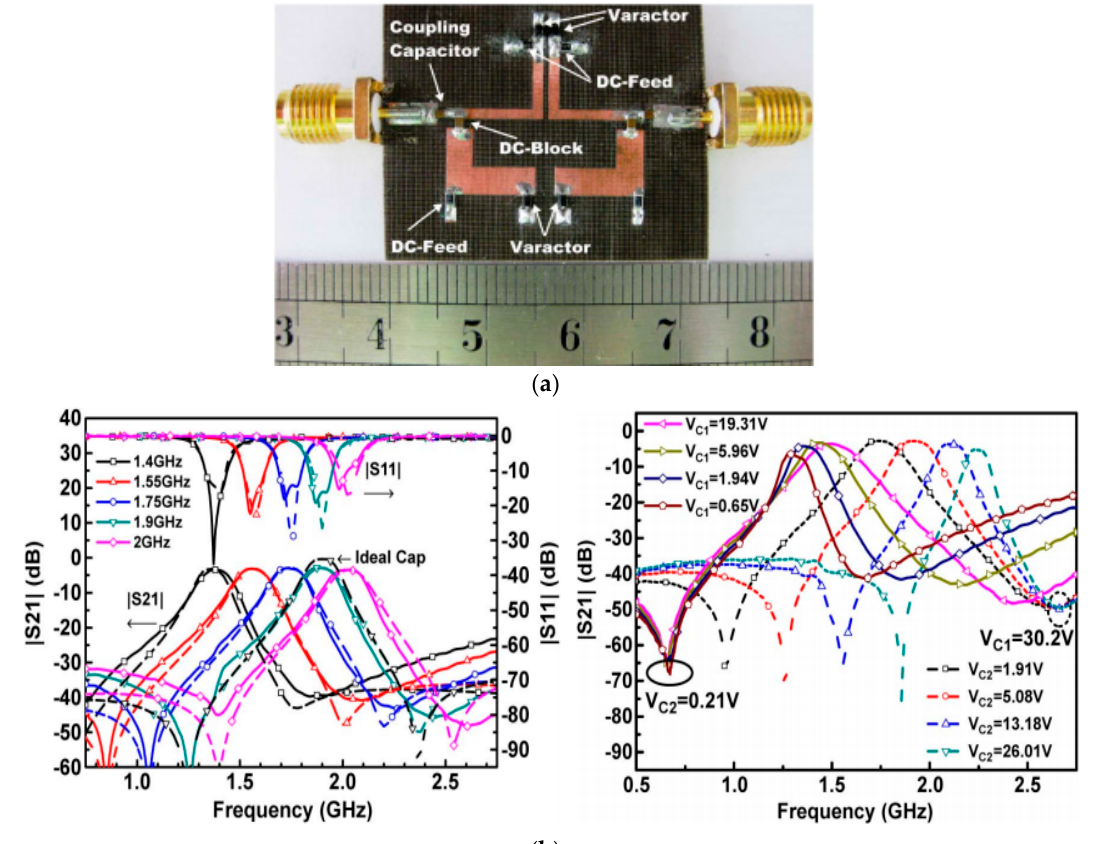
Figure 3. The reconfigurable filter reproduced from [30]. 2020, IEEE: ( a ) prototype structure; ( b ) S-parameter performance.